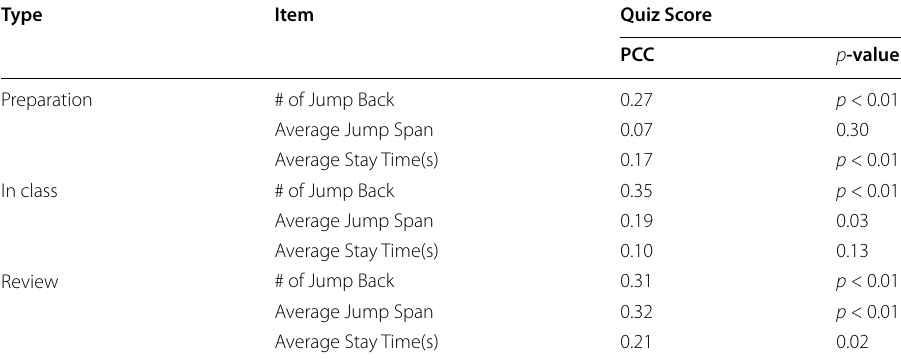
Table 3 Partial correlation results